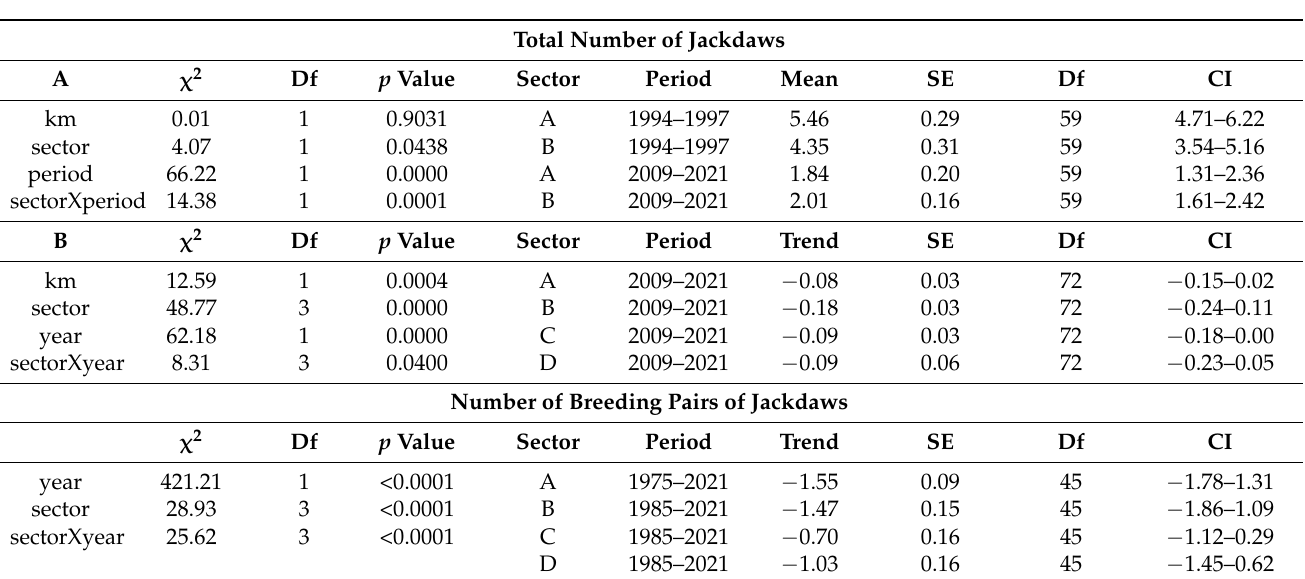
Table 1. Models obtained to assess changes in the total number and number of breeding pairs of jackdaws during the breeding season in gypsum cliffs and post hoc tests. ( A ) Comparison between sectors 1 and 2 between 1994–1997 and 2009–2021 and ( B ) among all sectors (1–4) from 2009 to 2021. mean: estimated marginal means; trend: estimated marginal means of trends; SE: standard errors; CI: confidence intervals. Model fits are shown in Figures S1 and